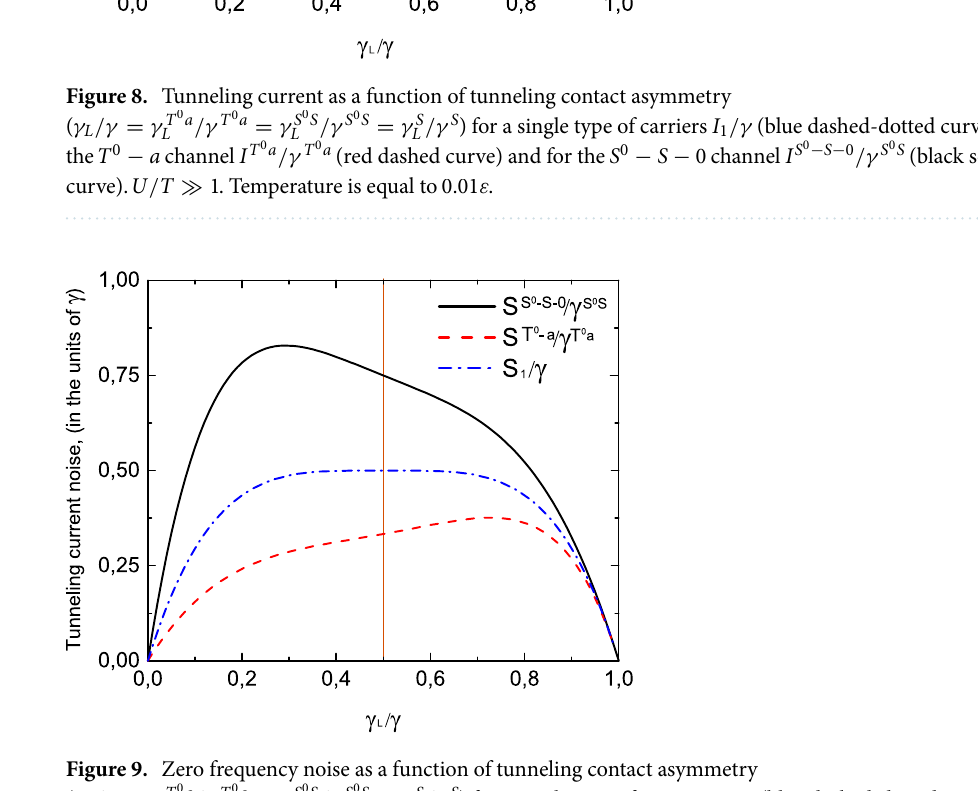
0 /γ S 0 S S 0 channel S S 0 S (black solid − − − −